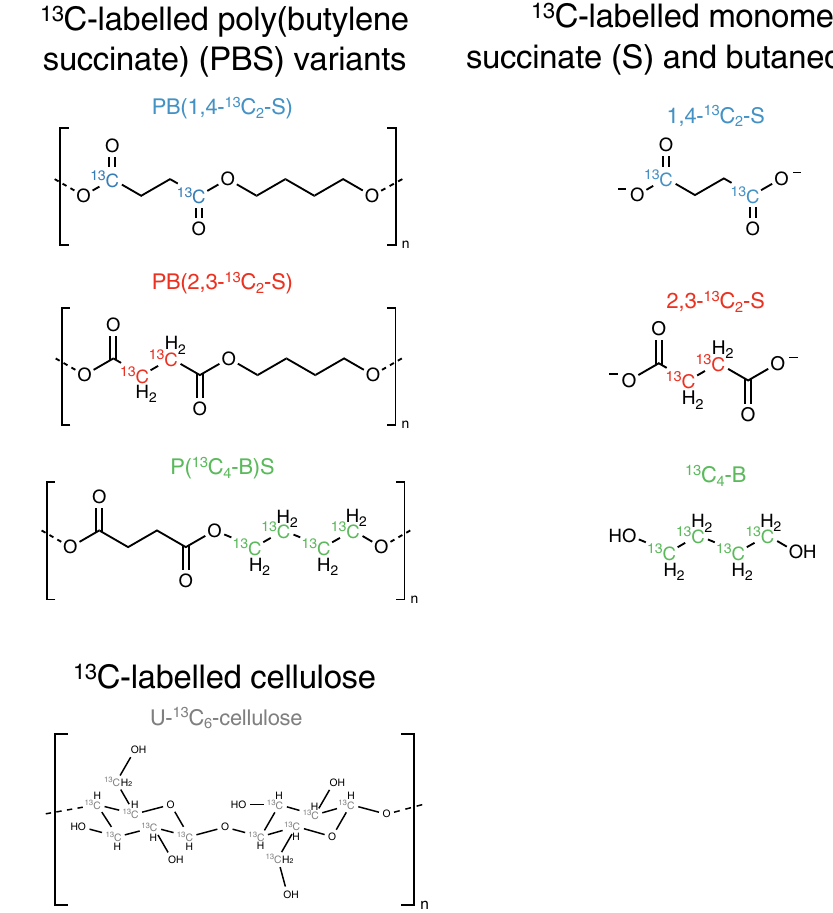
PB(2,3- 13 C 2 -S); and P( 13 C 4 -B)S), the corresponding 13 C-labelled monomers of succi- nate (S) and butanediol (B) (i.e. 1,4- 13 C 2 -S; 2,3- 13 C 2 -S; and 13 C 4 -B), and uniformly 13 C-labelled cellulose.